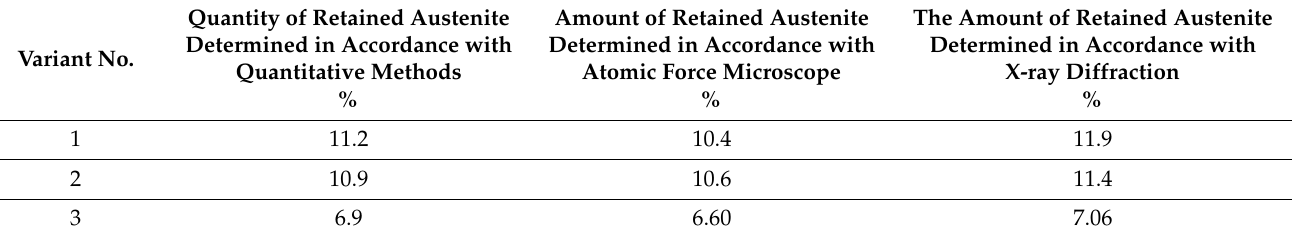
Table 5. Amount of retained austenite obtained in heat-treated wires.